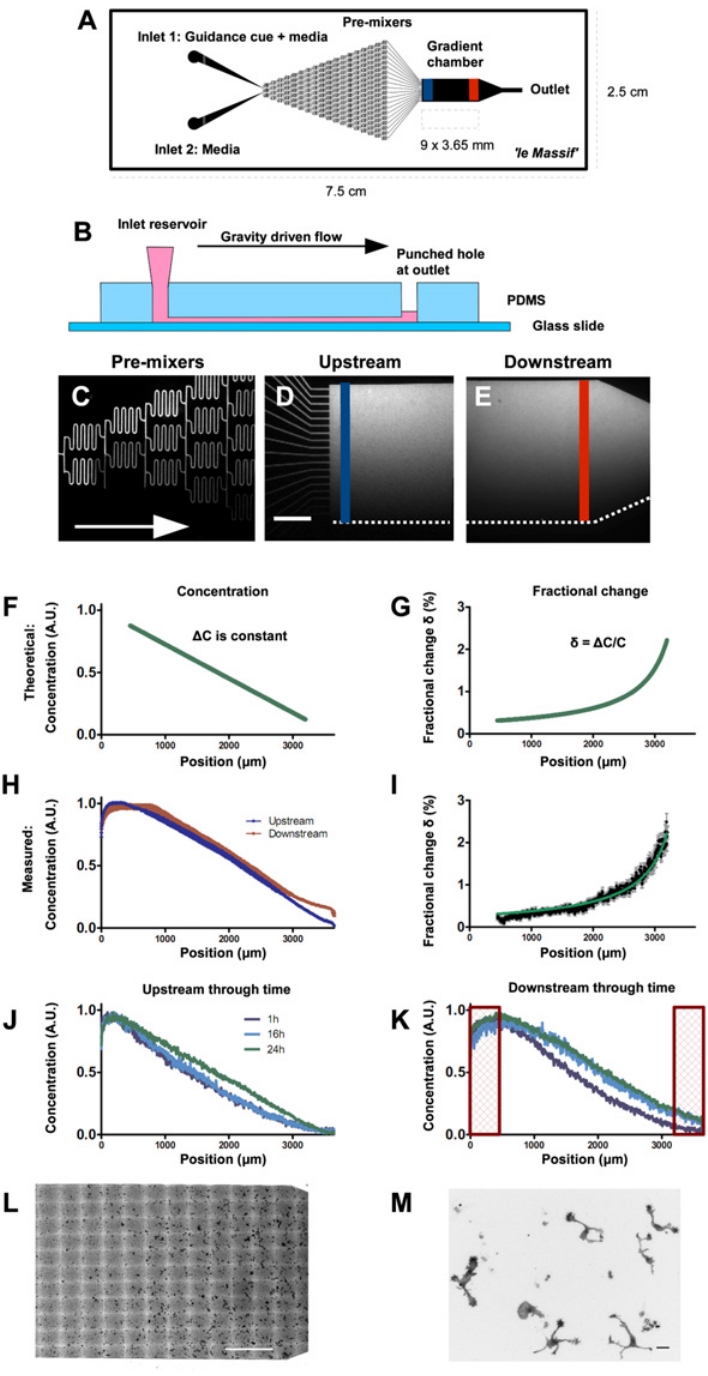
Fig 2. le Massif microfluidic gradient generator can produce shallow linear concentration gradients that are stable through space and time. (A) Drawing of the le Massif microfluidic device. Dimensions of the glass slide and the cell culture chamber are indicated with dashed lines. The blue line represents the upstream limit of the gradient chamber; the red line represents the downstream limit. The device generates linear concentration gradients using a pre-mixing microfluidic paradigm, in which a known concentration of cue is added to a reservoir at inlet 1 and culture media without guidance cue is added to inlet 2. (B) Schematic cross-section of le Massif microfluidic gradient generator. The fluid-filled inlet reservoirs drive a flow from left to right, with the fluid accumulating in the hole at the outlet. (C – E) The gradient visualized using